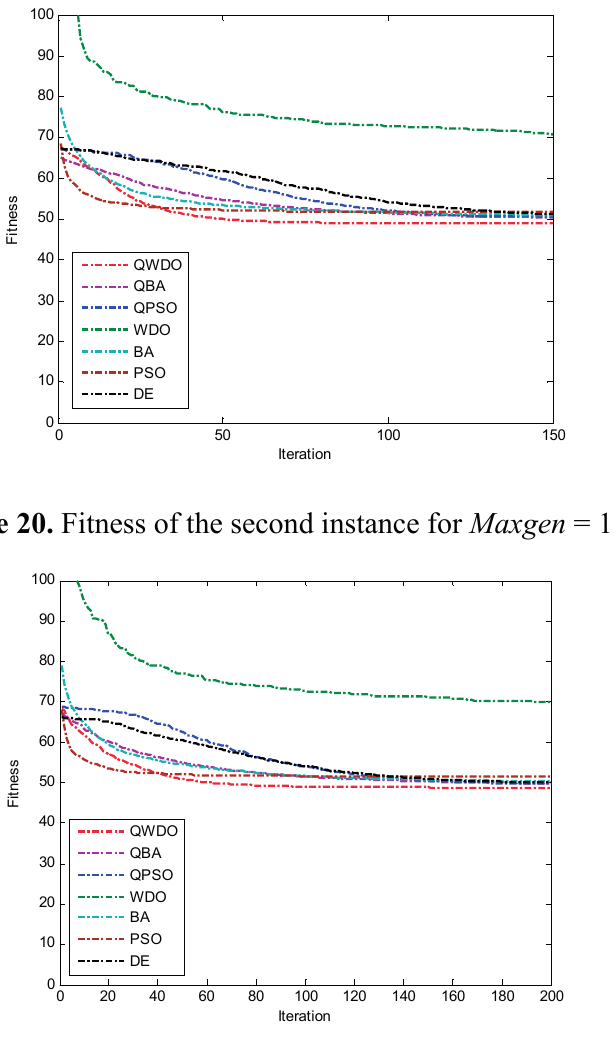
Figure 21. Fitness of the second instance for Maxgen = 200.